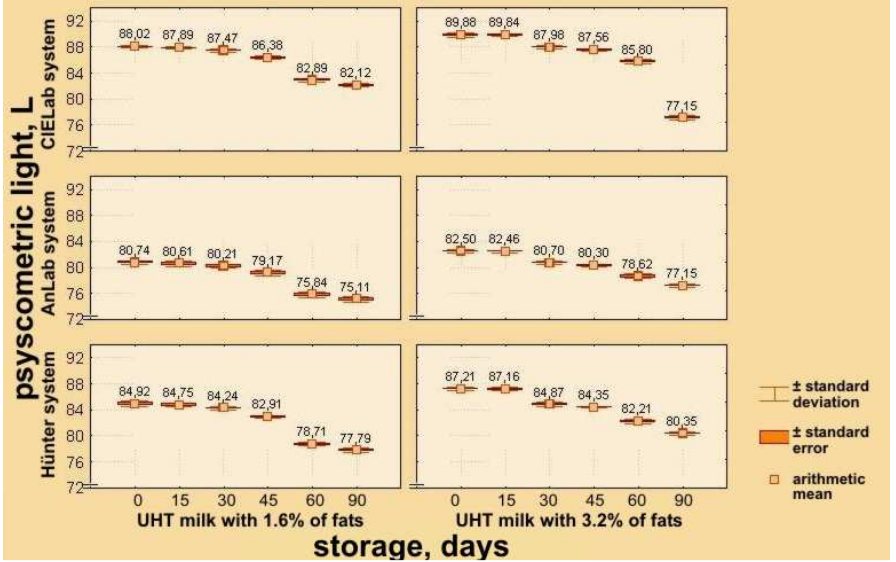
Figure 5 . Effects of storage time on changes of psychometric lightness of UHT milk samples with 1.6% and 3.2% milk fat in CIELab, ANLAB and Hünter’s